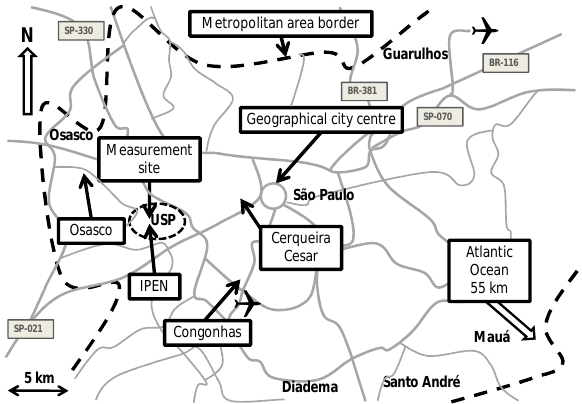
Fig. 1. Map of the metropolitan area of S˜ao Paulo. The measurement site is west of the geographical city centre. The metropolitan area of S˜ao Paulo is inhabited by 20 million